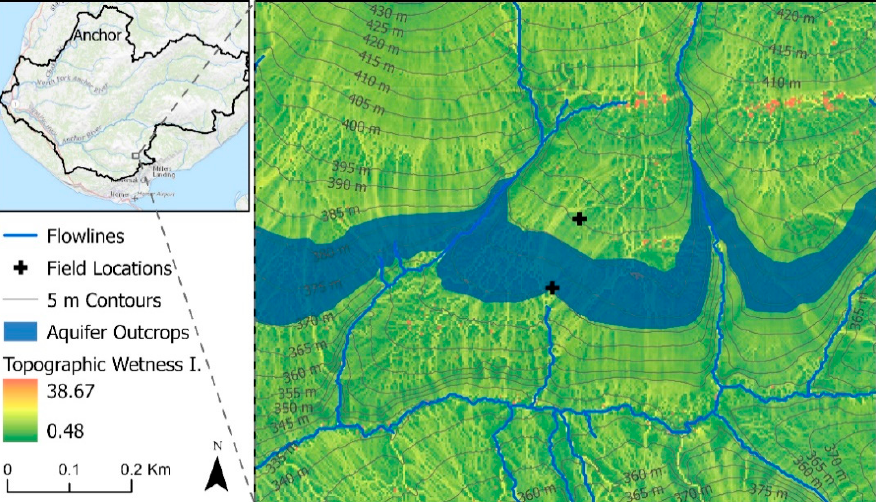
Figure 5. Example of implementing the four-step workflow to locate aquifer-outcrop groundwater discharge. Aquifer outcrops are first used to indicate regions where large volumes of groundwater discharge likely occur. Then each of the three topographic layers, i.e., contour lines, the initiation of flowlines, and sudden increases in TWI, are used to identify locations where channelized flows initiate. Springs are commonly found in these settings. In this case, the lowermost field point was preselected and found in the field to be 13 m from a spring. The uppermost field point was then visited, and the static water level was found to be ~2 m below the ground surface in a hand-dug